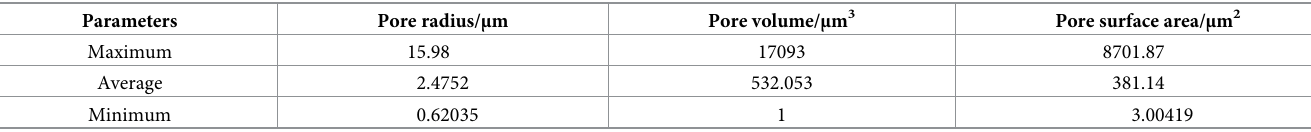
Table 1. Quantitative parameter statistics of pore model in carbon fiber